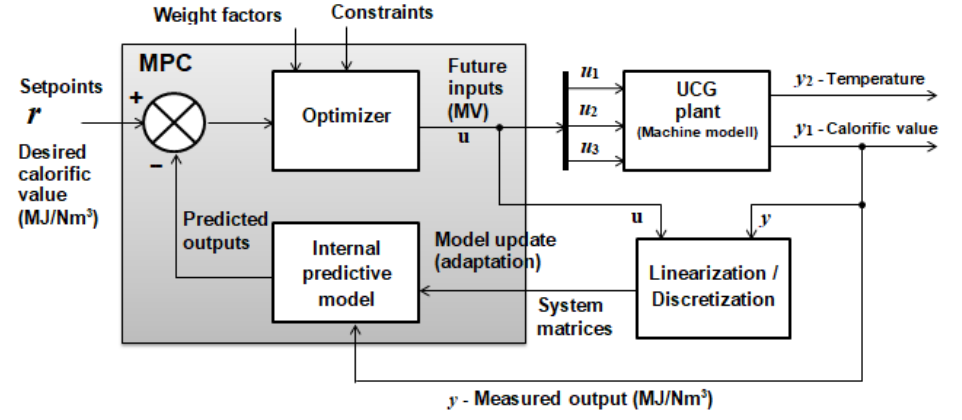
Figure 25. Structure of an adaptive MPC